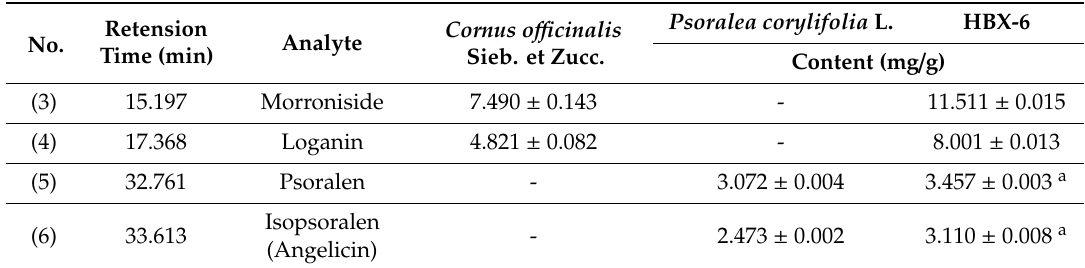
Table 2. Contents of four bioactive ingredients in C. officinalis , P. corylifolia and HBX-6.